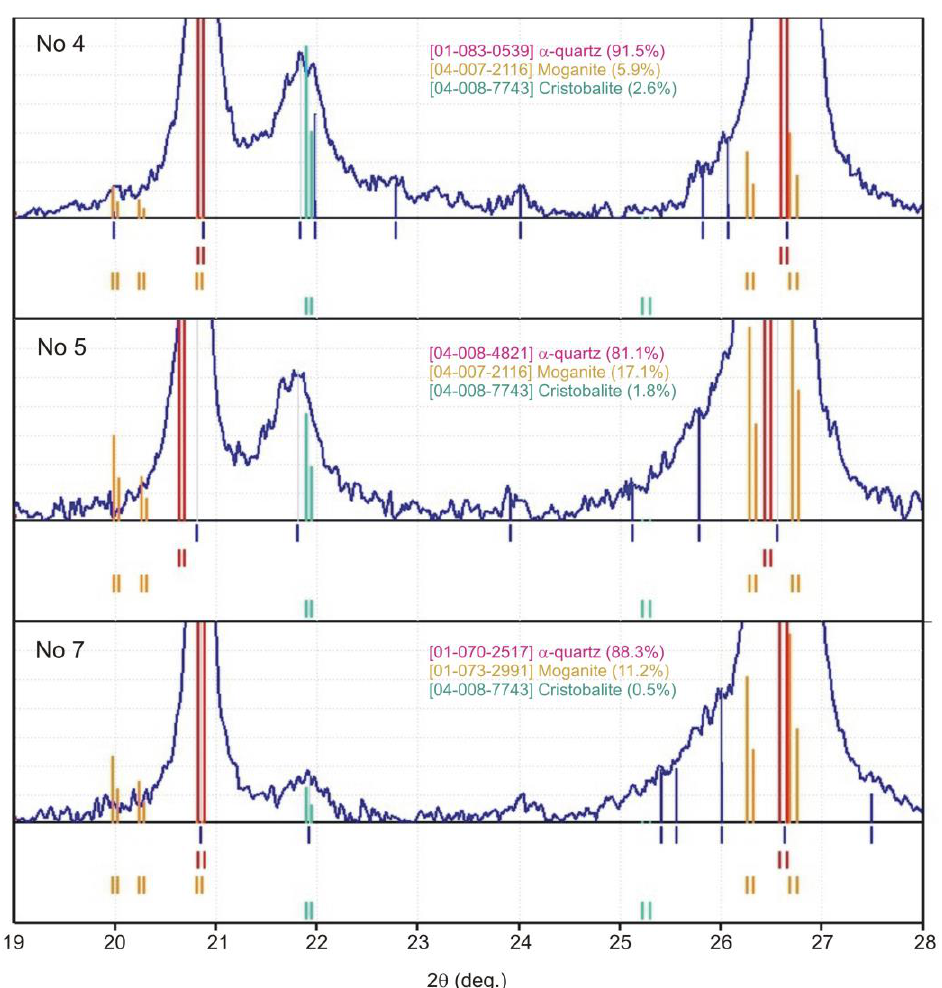
Figure 19. Fragments of X-ray diffraction patterns of the studied samples No. 4, 5, 7, in the range of angles 19–28 ◦ 2 θ (CuK α radiation) with the most intense peaks of cristobalite and moganite.